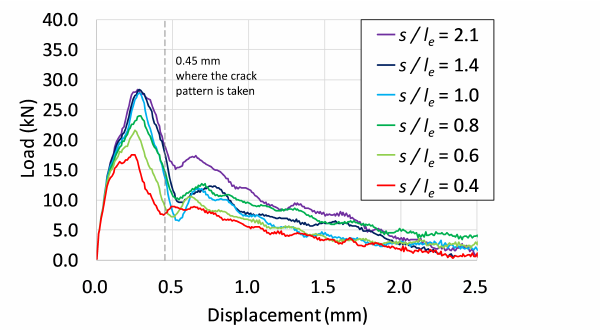
Figure 27. Load-displacement relationships with different distance to free edge.